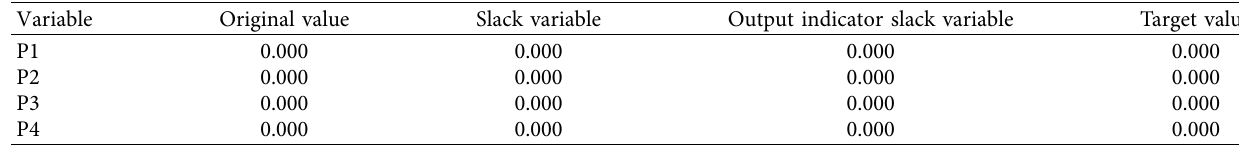
Table 4: Projection summary results of sample 6.